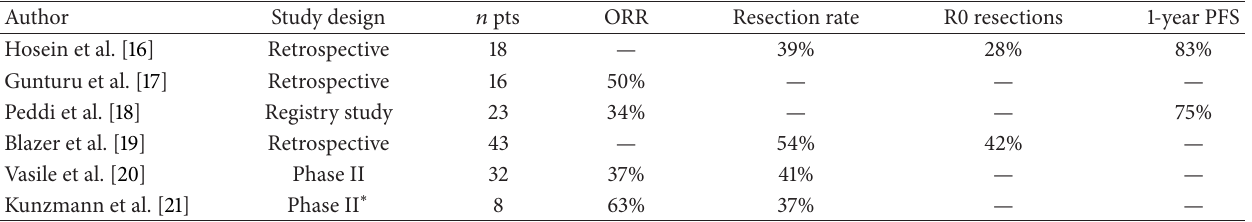
Table 2: FOLFIRINOX regimen in patients with borderline resectable or locally advanced unresectable pancreatic cancer.